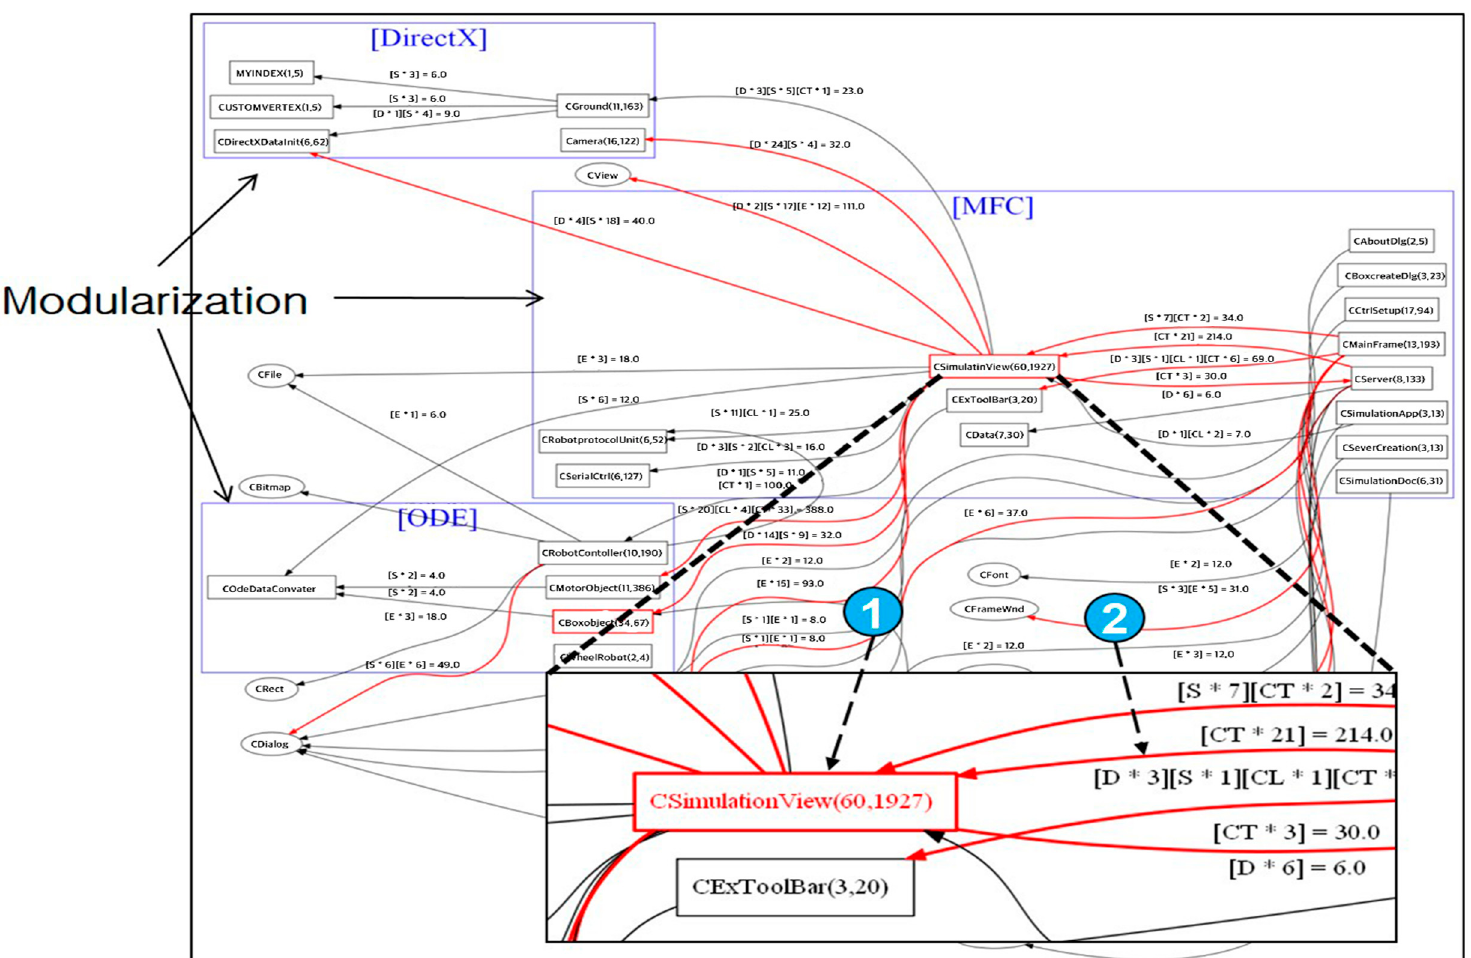
Figure 5. The inner code architecture of the multiple-joint robot simulator after refactoring.